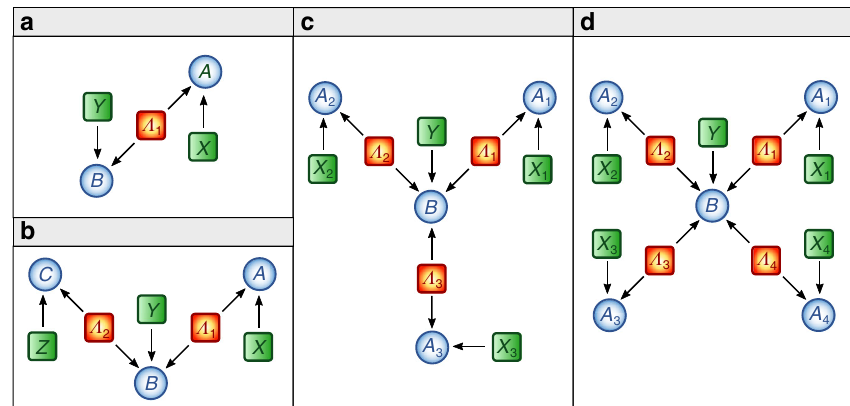
Fig. 1 Directed acyclic graph (DAG) representation for the star scenario with different number of sources. a Causal structure of the standard Bell scenario in which a single source Λ 1 mediates the correlations between the two measurement stations with outcomes A and B and measurement choices X and Y , respectively. b DAG for the bilocal scenario where two independent hidden variables Λ 1 and Λ 2 distribute the correlations to three measurement stations with outcomes A , B , and C and choice of measurements X , Y , and Z , respectively. c , d DAG for the star-network with three and four independent sources Λ 1 , Λ 2 , Λ 3 , and Λ 1 ; ¼ ; Λ 4 , respectively. Each non-central measurement station has outcomes A i (measurement choices X i ) and the central has outcome B (measurement choices Y